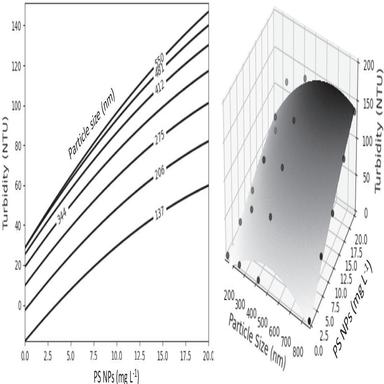
Correlation between turbidity, PS NPs concentration and particle size in the low range of concentration ( = 0 − 20 mg/L).